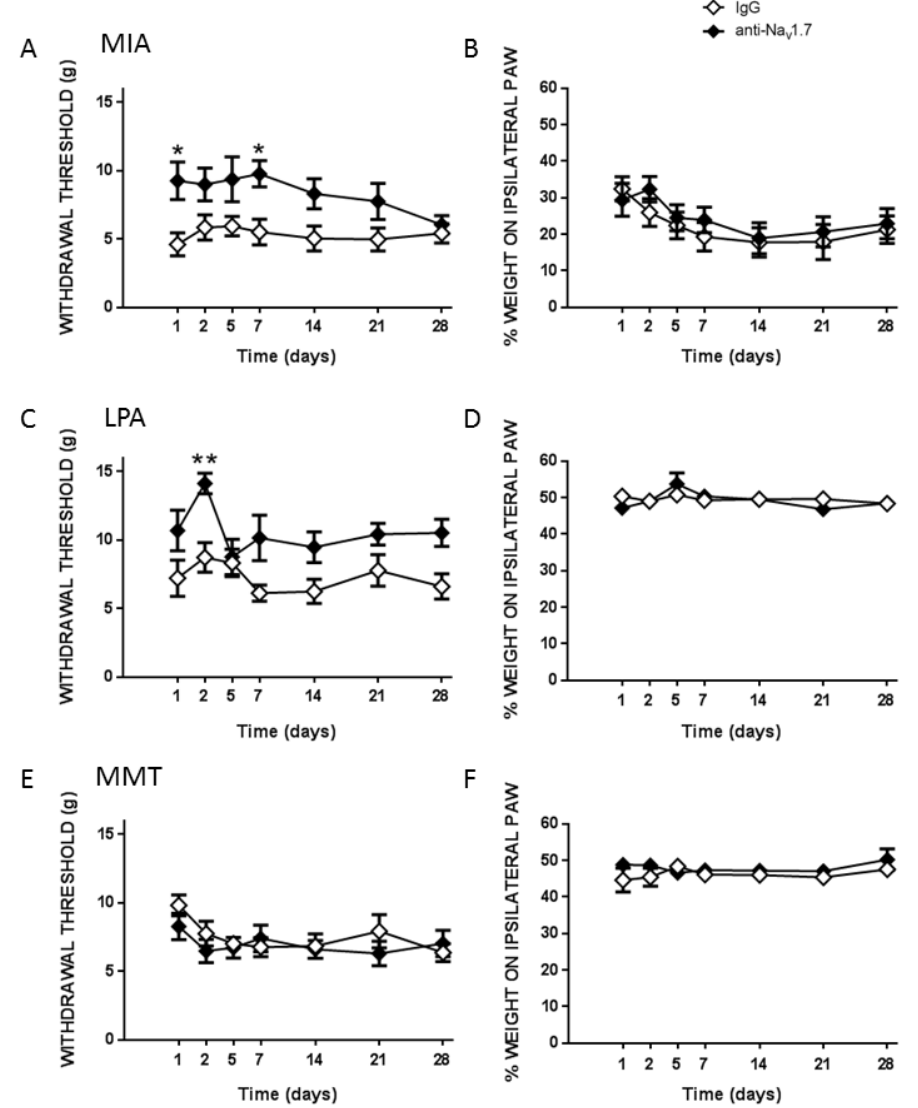
Figure 6. Chronic Effect of anti-Na v 1.7 Treatment on Joint Pain. Following a single, local injection of anti-Na v 1.7 (25 μg in 50 μL), hindpaw mechanosensitivity was significantly reduced over 28 days in MIA ( A ) and LPA ( C ) animals, but not MMT rats ( E ). Prolonged blockade of Na v 1.7 had no effect on hindlimb weight bearing over the 28-day time-course ( B , D , F ). * p < 0.05, ** p < 0.01, two-way RMANOVA with Bonferroni’s post hoc test. Data are expressed as mean ± S.E.M ( n = 8–9 animals/group).